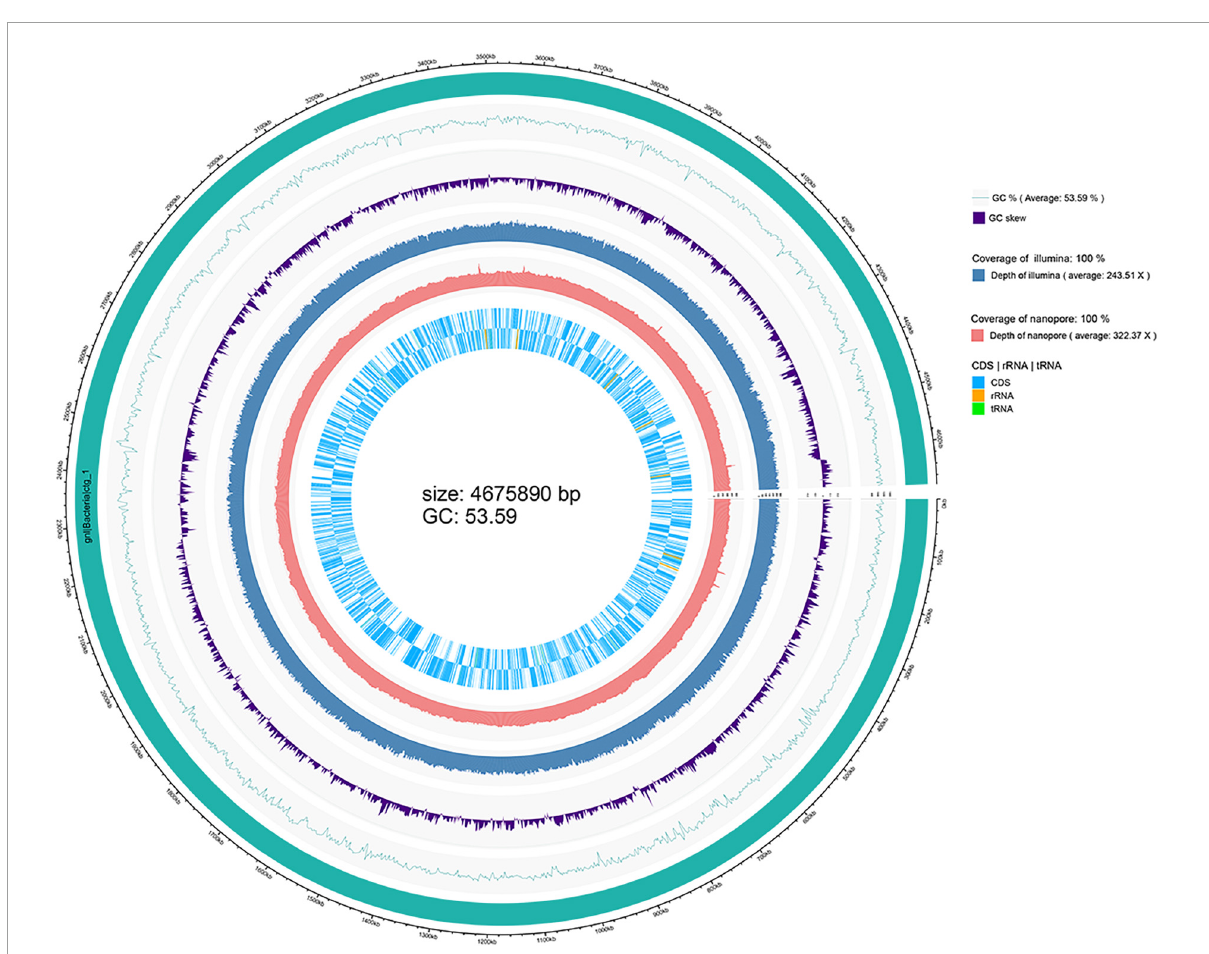
FIGURE2 Circular visualization of the complete genome of Dickeya zeae strain